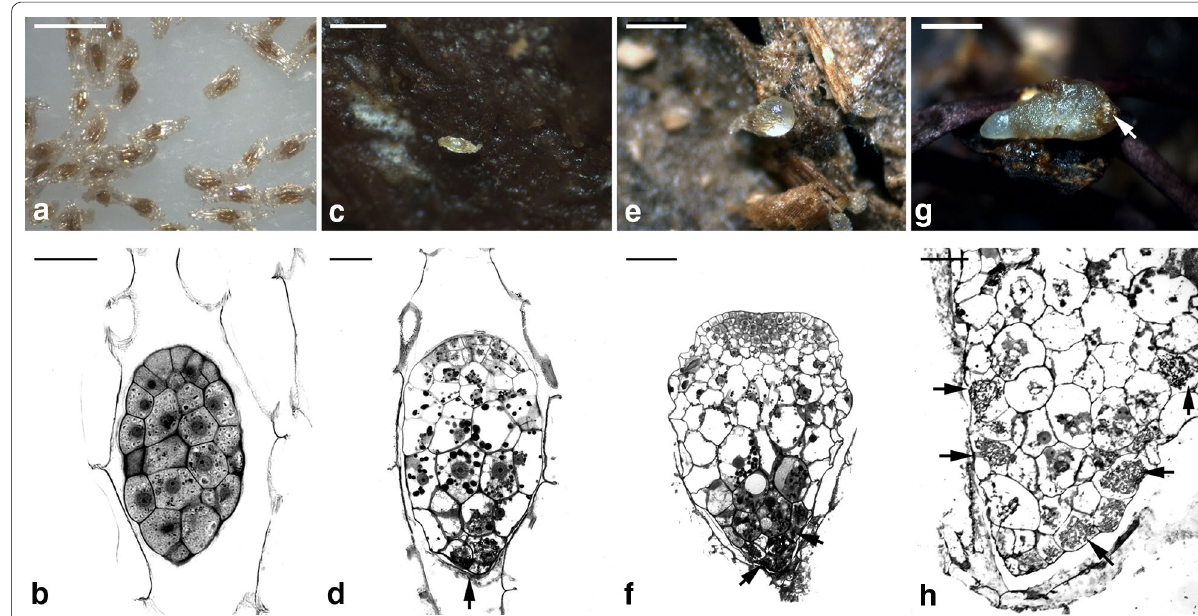
Fig. 1 The symbiotic seed germination of G. elata associated with Mycena . a Mature seeds of G . elata . Scale bar mature seed. The embryo is covered by a thin testa. Scale bar d In the enlarged embryo, fungal hyphae have penetrated the embryo through the suspensor end cell (arrow). Scale bar of inoculation, the embryo has ruptured the seed coat, resulting in the formation of a protocorm. Scale bar colonized the basal region of the developing protocorm. Scale bar The basal region of the protocorm is indicated by an arrow. Scale bar protocorm, and fungal hyphae (arrows) are restricted at the basal region. Scale bar